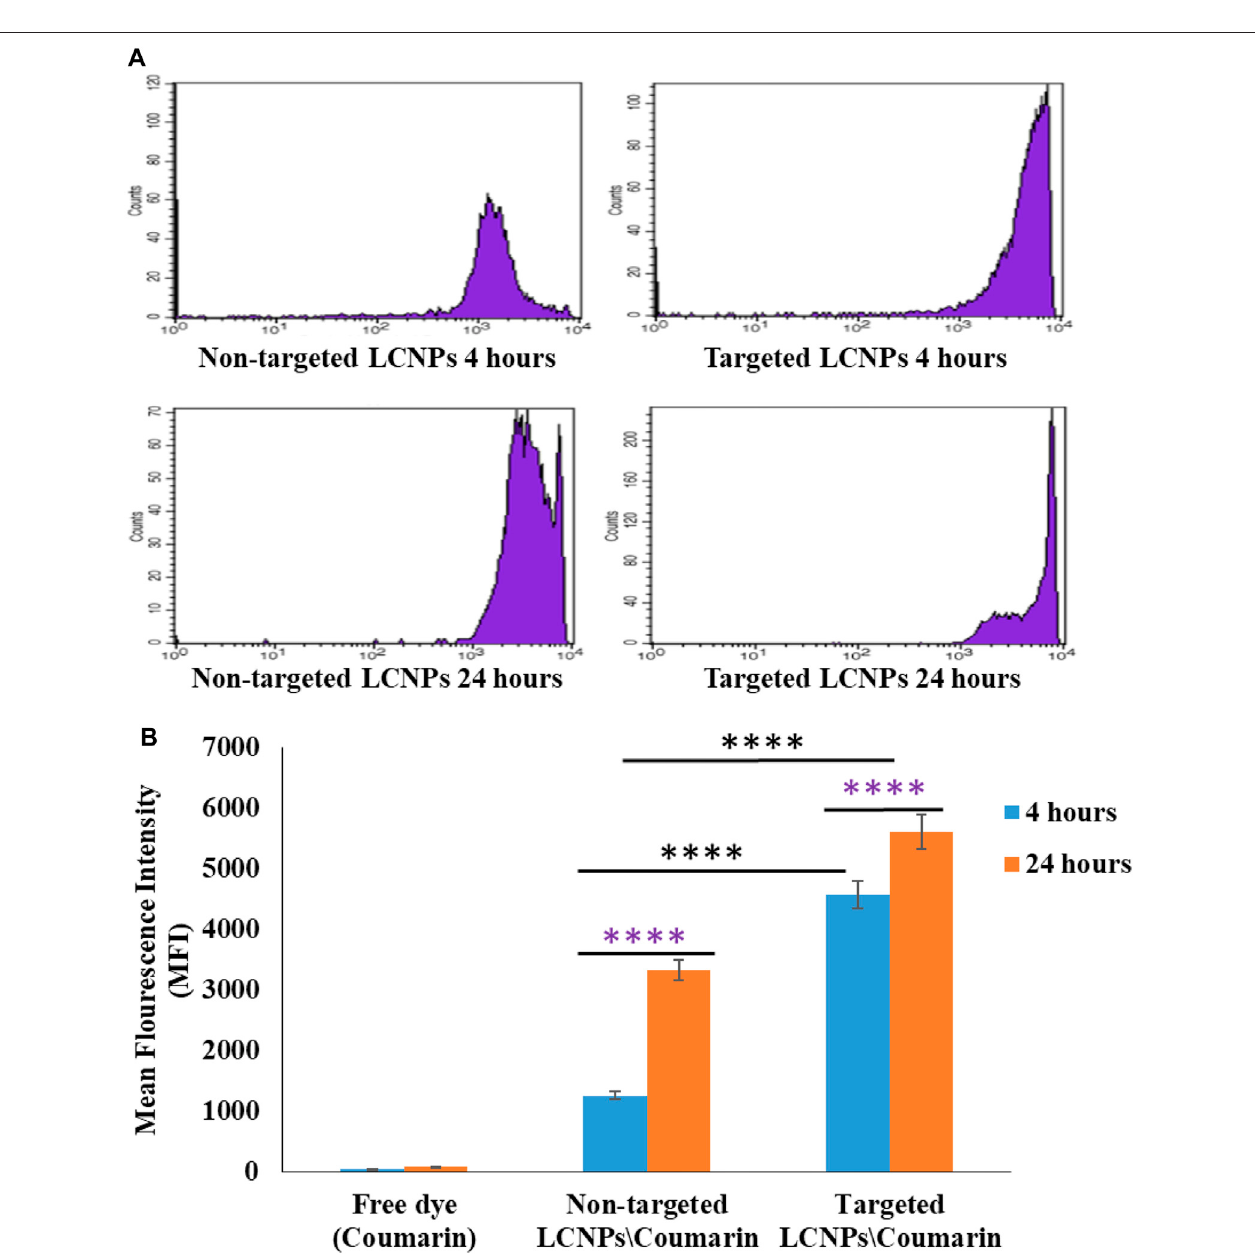
FIGURE 8 | (A) Flow cytometry histogram pro fi les of MCF-7 breast cancer cell line treated with coumarin-loaded non-targeted and Lf-targeted coumarin-labeled LCNPs for 4 and 24 h at 37 ° C. (B) Quanti fi cation of cellular level of mean fl uorescence intensity in MCF-7 cells after 4- and 24-h incubation with free coumarin dye, non- targeted, and Lf-targeted coumarin-labeled LCNPs after 4 and 24 h at 37 ° C ( n = 3, **** p <